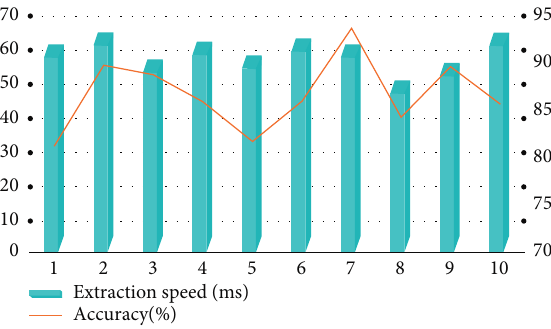
Figure 12: Music feature extraction effect based on digital music waveform